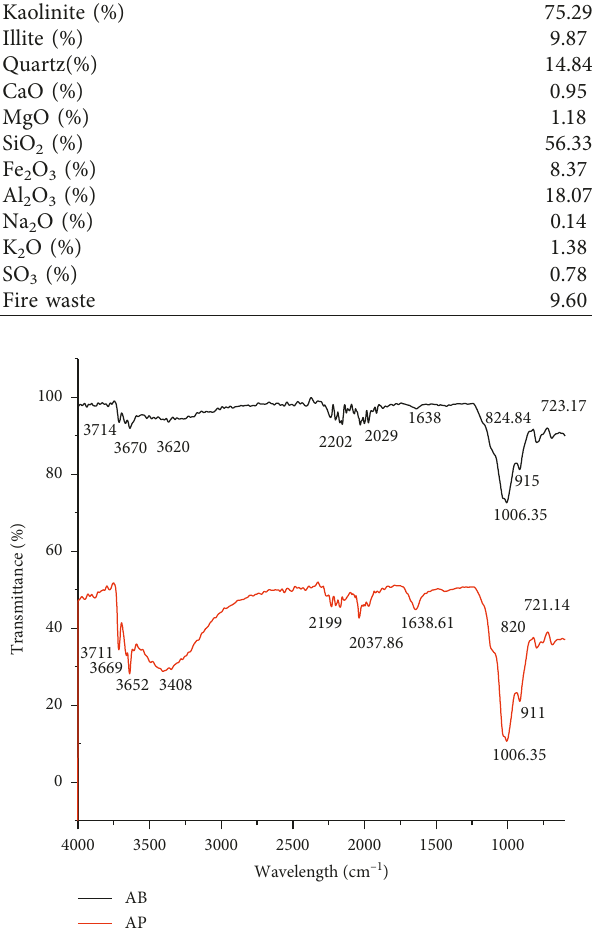
Figure 2: FTIR spectrum of raw (AB) and purified (AP) Sejnane clay.